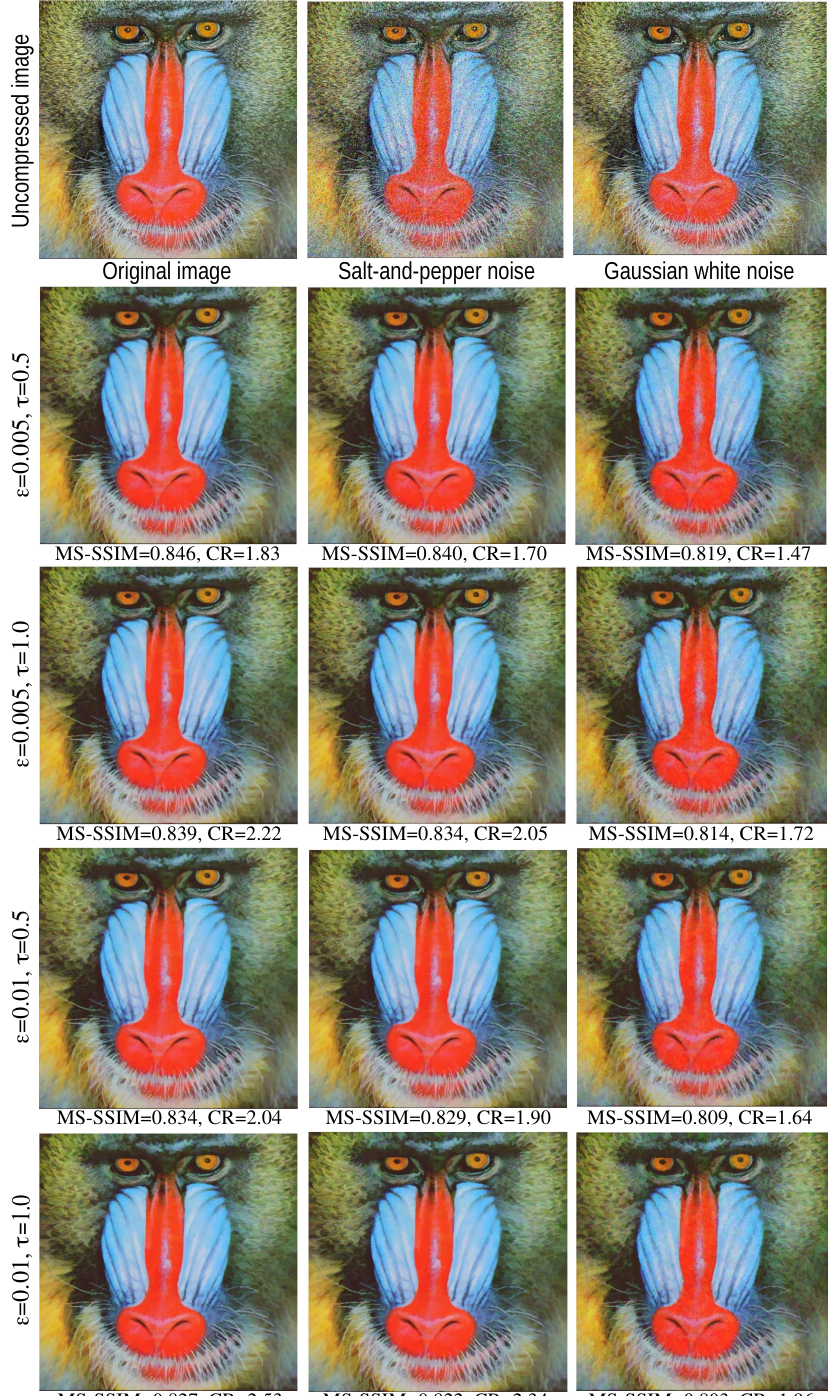
Figure 12. Results of CDMD on an image with fine-grained detail (left column) additionally corrupted by small-scale noise (middle and right columns), for different values of the (cid:101) and τ